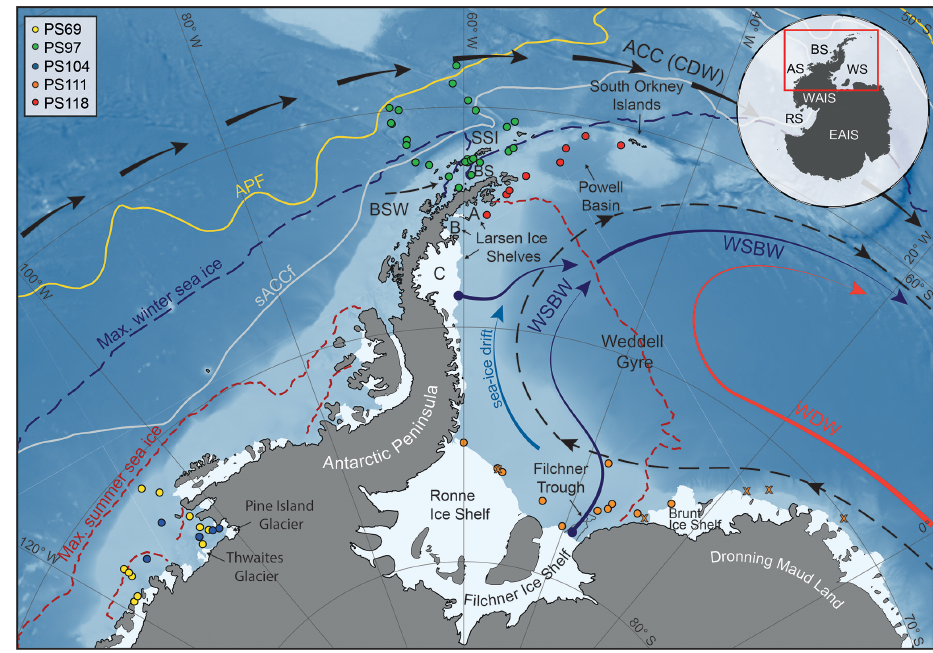
Figure 1. Map of the study area (location indicated by the red box in the inset) including all 41 sample locations (see different coloured dots for individual RV Polarstern expeditions in the top-left corner; for detailed sample information, see Table S1 in the Supplement) and the main oceanographic features. Maximum summer and winter sea-ice boundaries are marked by dashed red and blue lines respectively (Fetterer et al., 2016). The orange crosses in the Weddell Sea indicate samples with low biomarker concentrations close to the detection limit, to which we assigned a PIPSO 25 value of 1. The abbreviations use in the figure are as follows: ACC – Antarctic Circumpolar